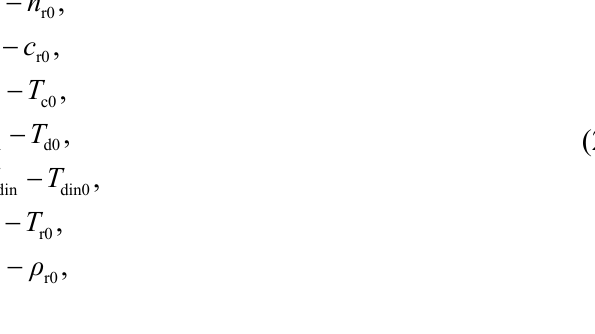
Table 2. Meaning of the variables in Equation